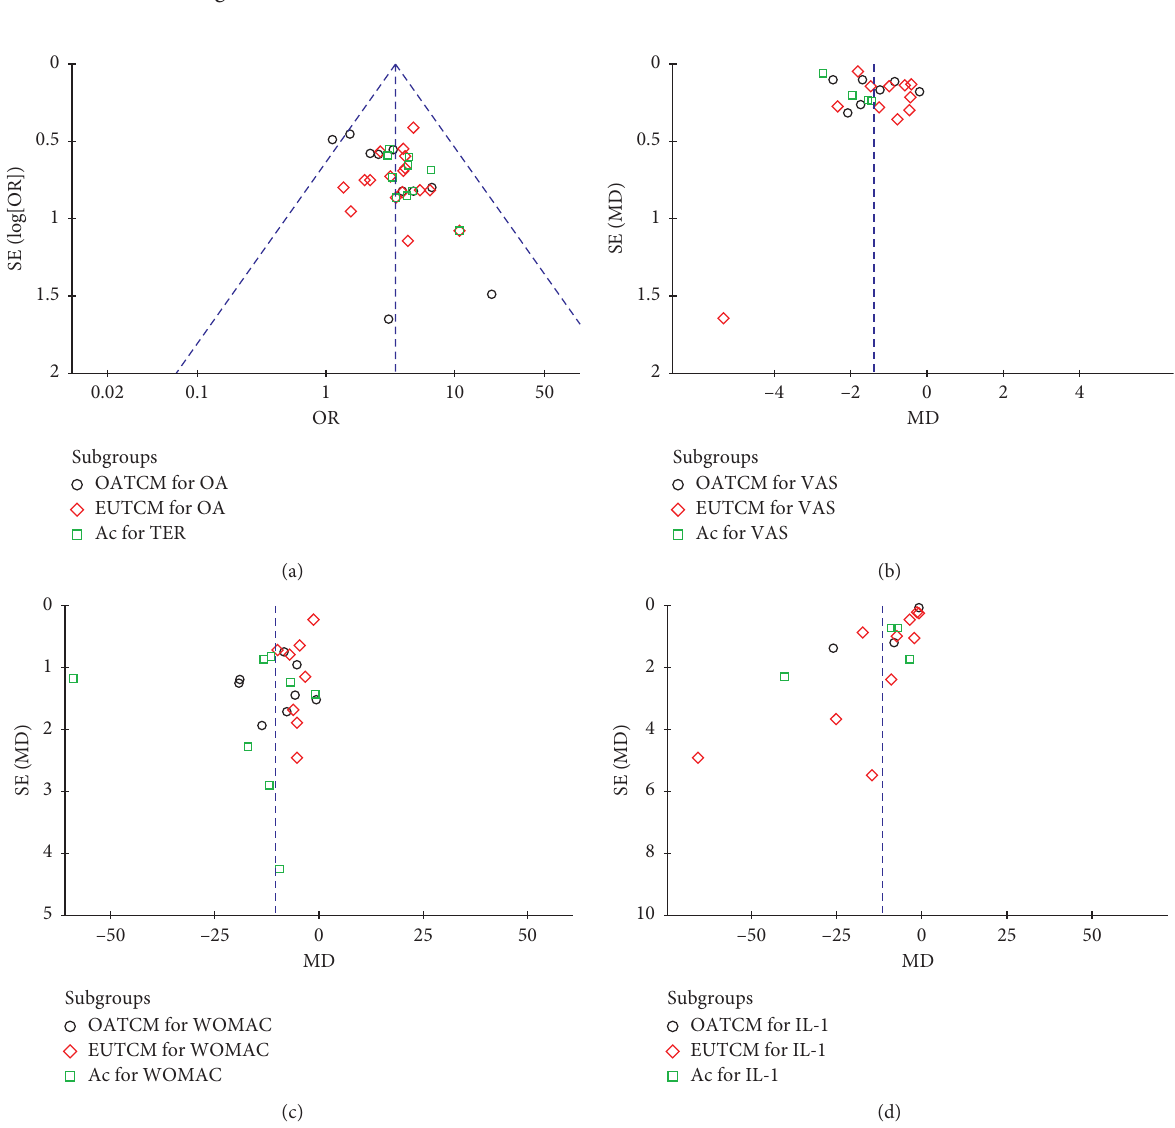
Figure 9: Funnel plot for the publication bias. (a) The plot of TER, (b) the plot of VAS, (c) the plot of WOMAC, and (d) the plot of